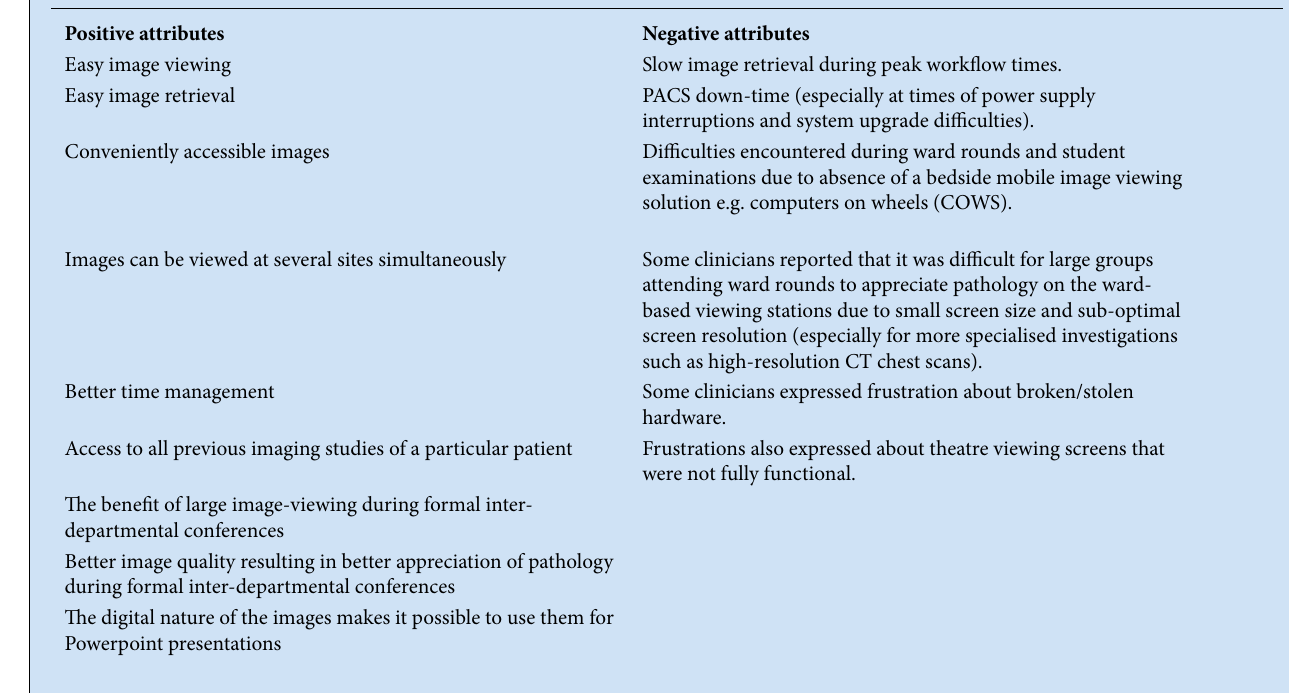
Table I. Summary of ‘free text’ comments